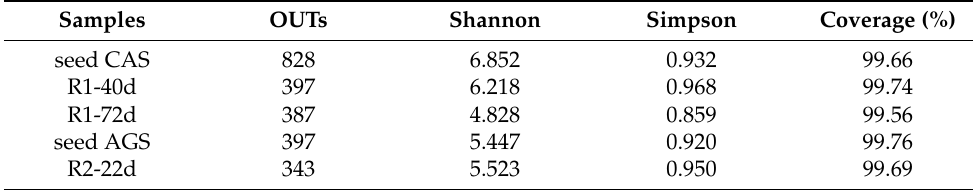
Table 2. The alpha diversity indexes for different sludge